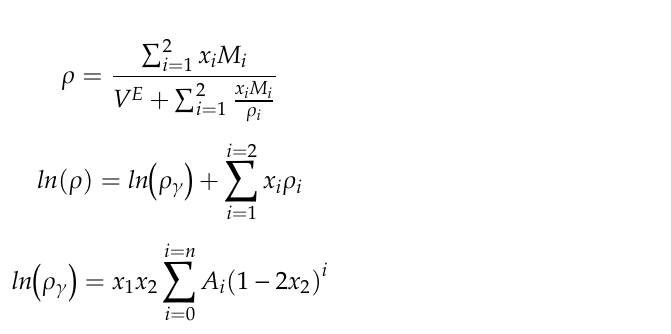
Table 5. Temperature dependency of the Redlich–Kister coe ffi cients ( A i ) for the density deviation ln ( ρ γ ) of di ff erent aqueous amine